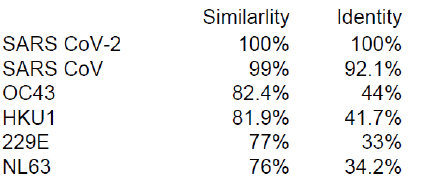
Figure 2. Multi-alignment analysis of the spike S2 domain of SARS-CoV-2, SARS-CoV, and alpha (229E and NL63) and beta (OC43 and HKU1) human coronaviruses. Similarity and identity are indicated as orange boxes and red boxes, respectively.